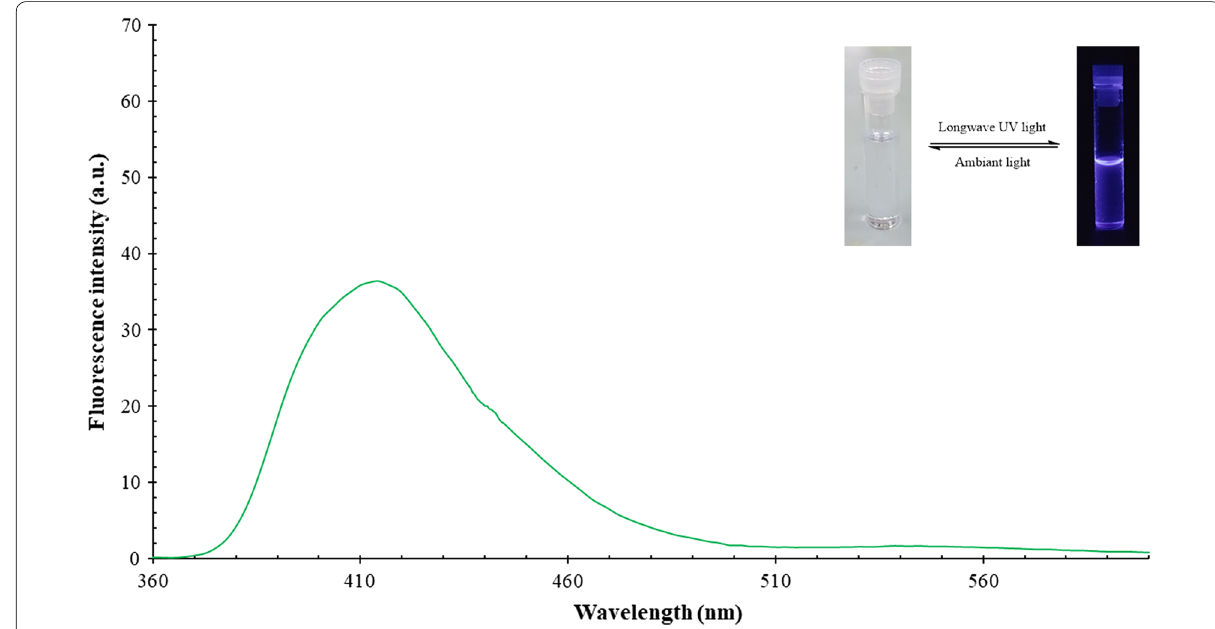
Fig. 13 Fluorescence spectrum of AMINE